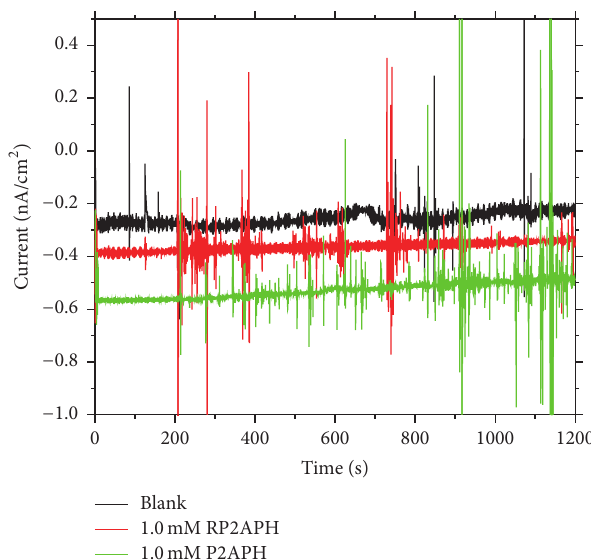
Figure 5: Current noise for CS in the absence and presence of P2APH and RP2APH (1.0mM) in 1M HCl 29 ± 0.2 ∘